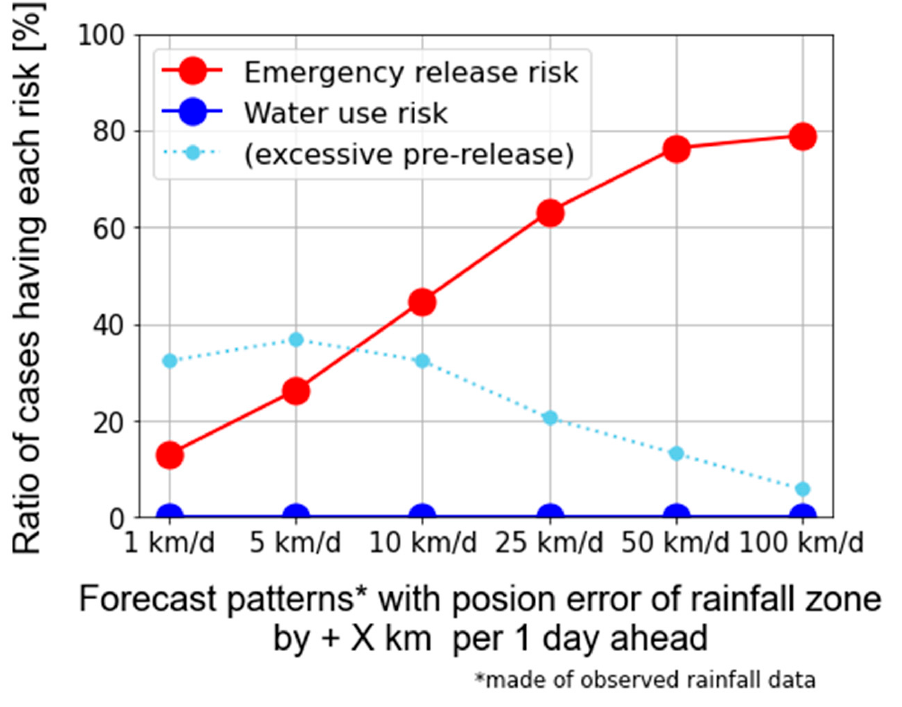
Figure 20. Ratio (%) of cases with an emergency release risk in all pre-release front cases (red), water use risk and excessive pre-release in all pre-release and quasi-pre-release front cases (blue, light blue) when using rainfall forecasts with various position errors of rainfall.